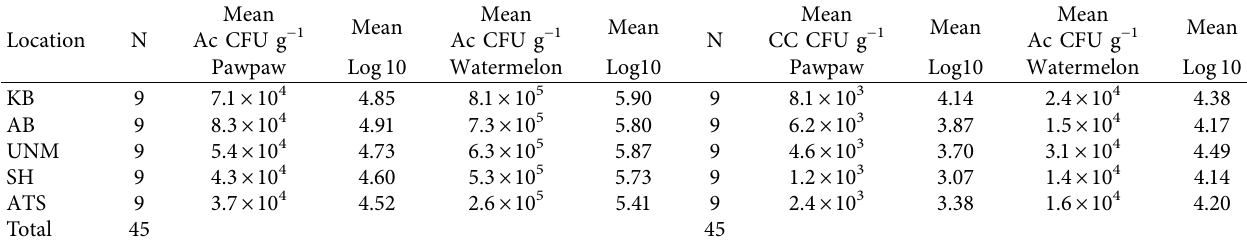
Table 3: Mean aerobic counts and mean coliform counts of packaged pawpaw and watermelon from various locations. Location